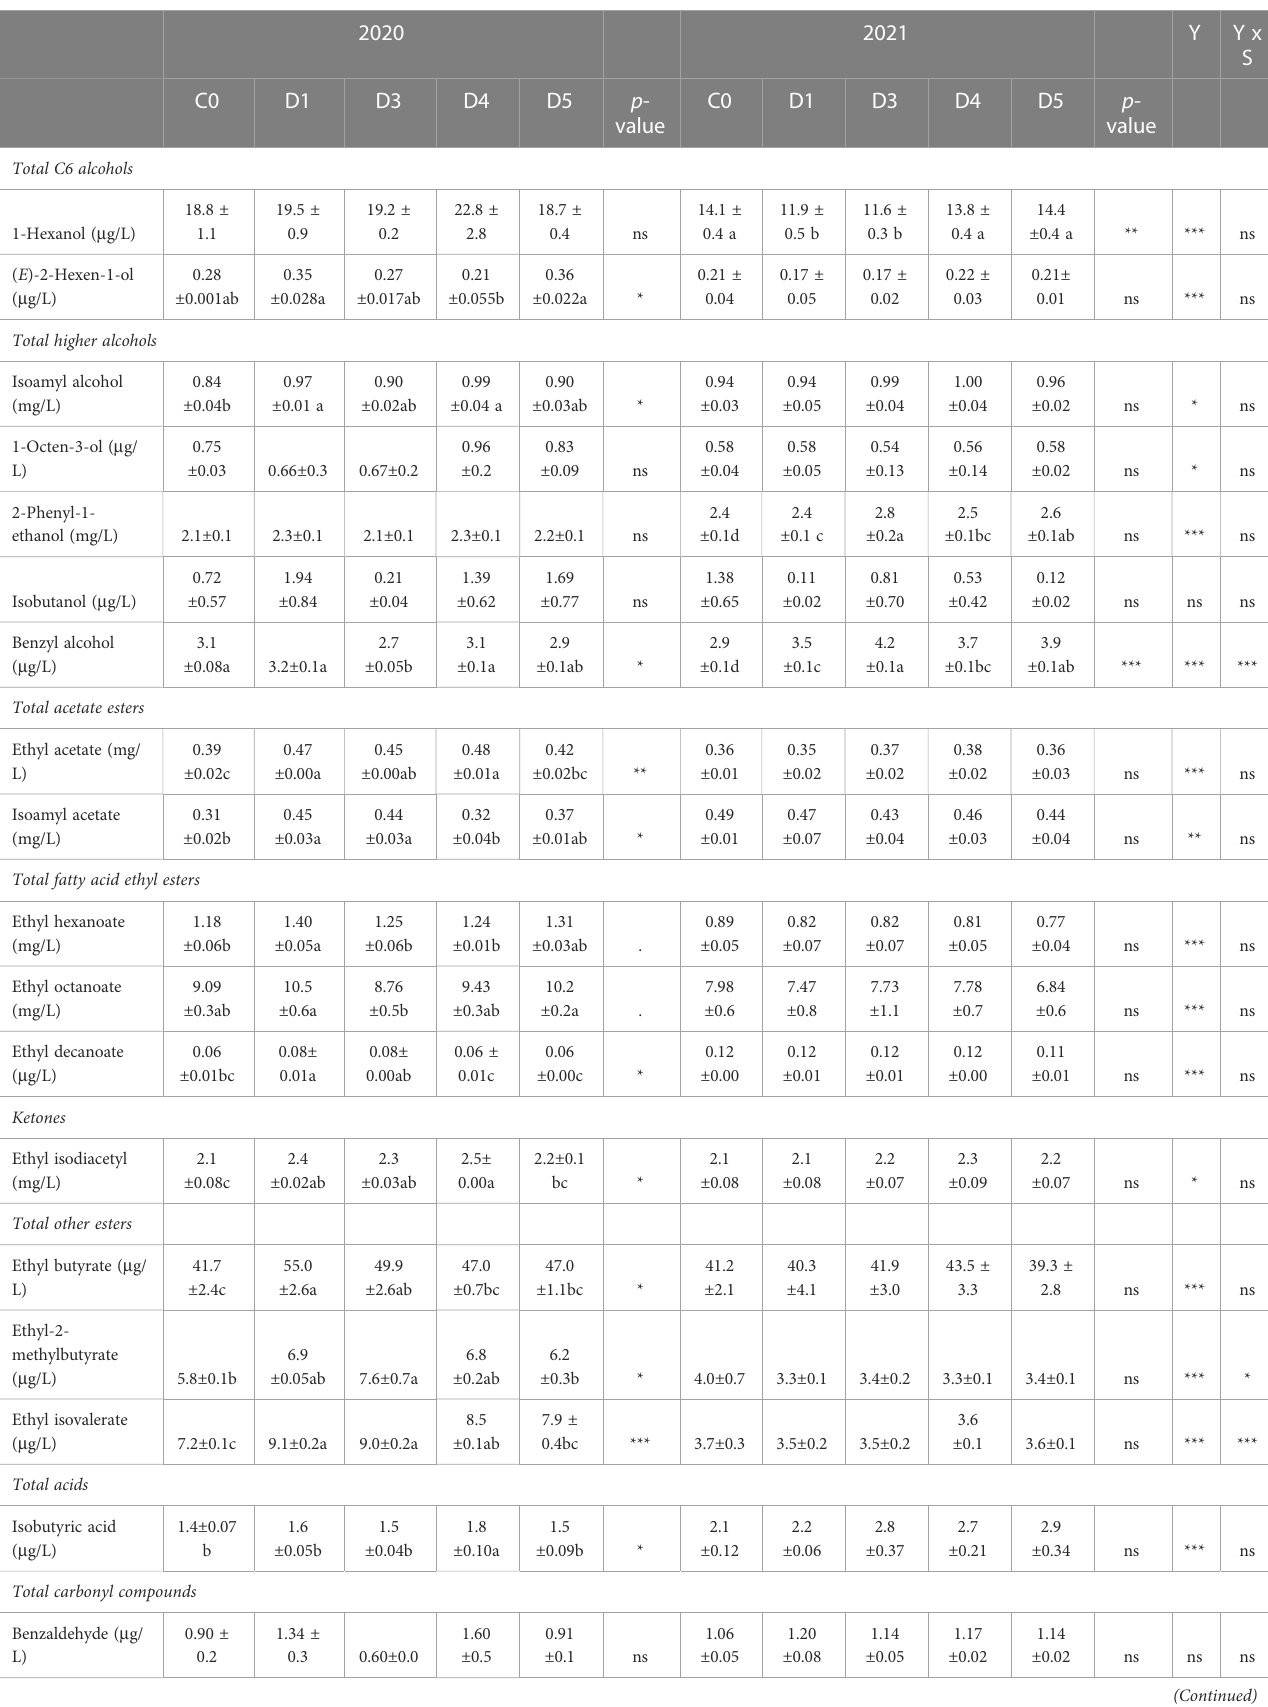
TABLE 3 Aromatic composition of Cabernet Sauvignon wines from grapevines subjected to different photoselective shade fi lm treatments in Oakville, CA, USA in 2020 and 2021 growing seasons a